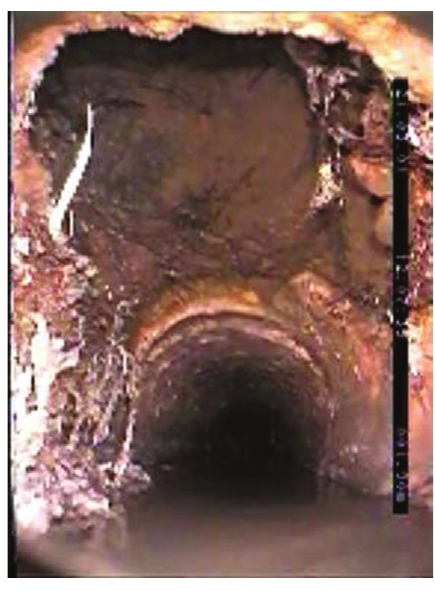
Fig. 5. Sewer collapse, an air void visible above the missing fragment of the sewer